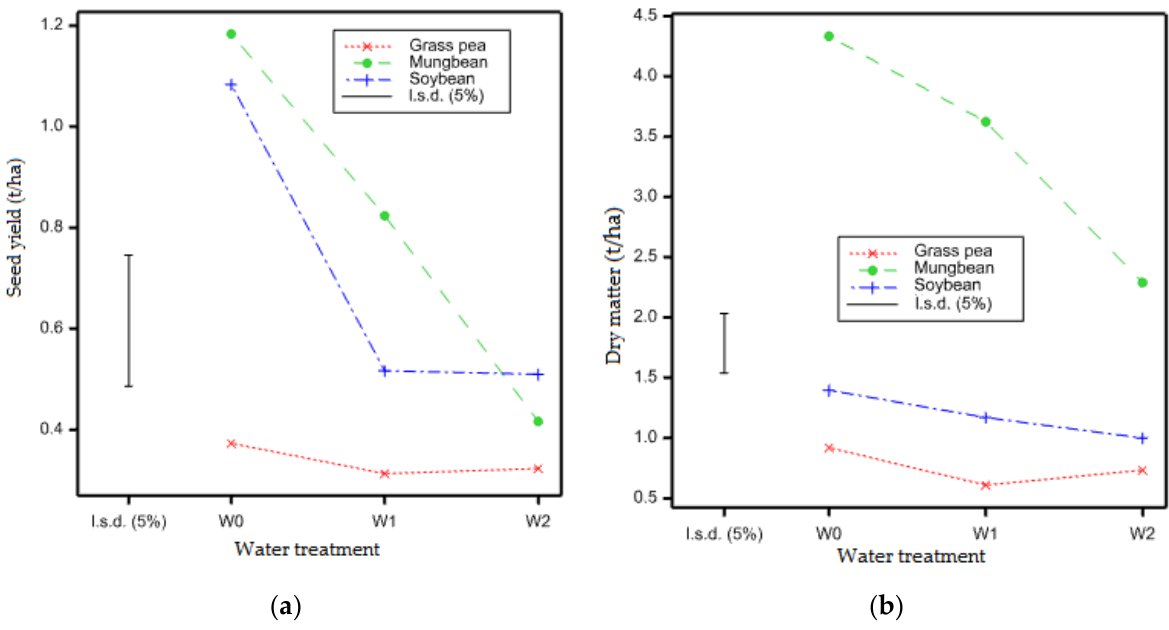
Figure 5. Water treatment × species interaction for ( a ) seed yield (t/ha) ( p = 0.005) and ( b ) dry matter production ( p < 0.001) at the Vemase site in 2018.